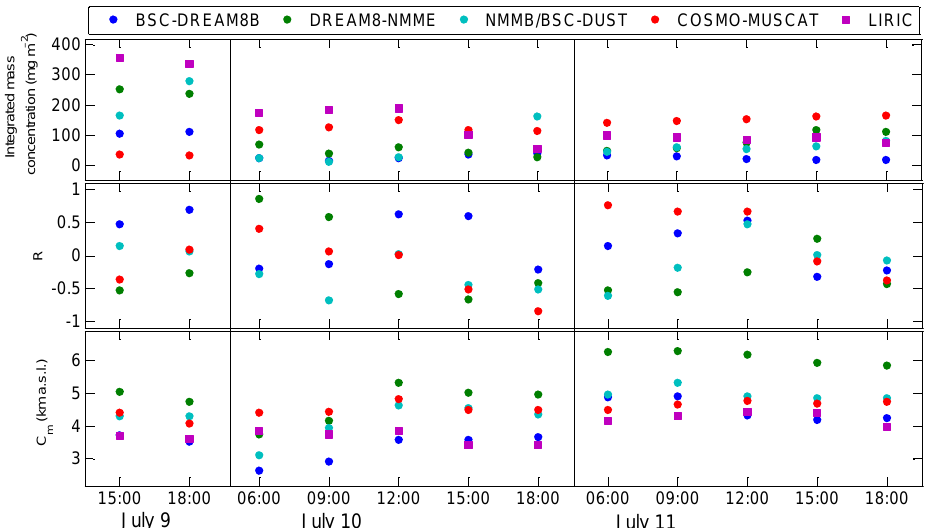
Figure 12. (From top to bottom) Time series of the integrated mass concentration values (above 2km in altitude) retrieved from LIRIC and the four evaluated model vertical profiles for the period between 15:00UTC on 9 July 2012 and 18:00UTC on 11 July 2012. Time series of the correlation coefficient R , between LIRIC-derived mass concentration profiles, and each one of the four evaluated models for the same period. Time series of the dust center of mass, C m , obtained from LIRIC and the model profiles.